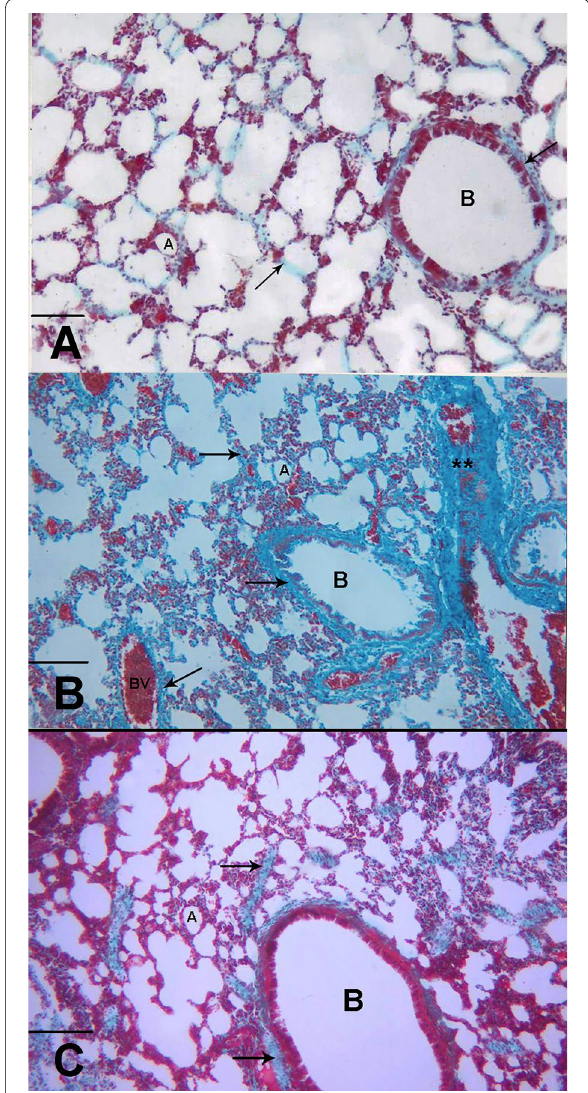
Fig. 3 A A Photomicrograph of lung in the control group showing normal distribution of thin layer of collagen fibers in the interalveolar septa and the wall of the bronchiole ( ). (Masson’s trichrome, → scale bars 40 µm). B A Photomicrograph of lung in the CYP group = showing excessive increase in collagen deposition in the interalveolar septa, in the walls of the blood vessels and the walls of the bronchioles ( ). Large fibrotic areas are seen in the parenchyma (**). → (Masson’s trichrome, scale bars 40 µm). C A photomicrograph of = the lung of CYP BCX group showing marked decrease in collagen + deposition ( ). (Masson’s trichrome, scale bars 40 µm) ( A alveoli, B → = Bronchiole, BV blood